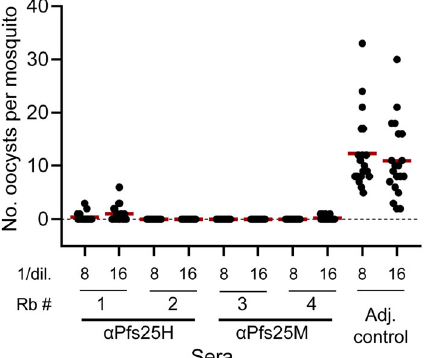
Fig. 2 Evaluation of the transmission-blocking activity of rabbit antisera raised against Pfs25H or Pfs25M compared to an adjuvant control using the standard membrane feeding assay (SMFA). Shown are the number of oocysts in a minimum of 20 mosquitoes per test sample ( (cid:129) ) and the average number of oocysts ( — ). The average inhibition of oocyst density (TRA) in percent was: Rb1 97.1, 90.7; Rb2 100, 100; Rb3 100, 100; and Rb4 100, 98.2 against the appropriate adjuvant controls (0%). All sera were heat- inactivated and dilutions (1/8 and 1/16) prepared that included supplement with human serum with active complement. The P. falciparum NF54 strain was used in the ex vivo SMFA.